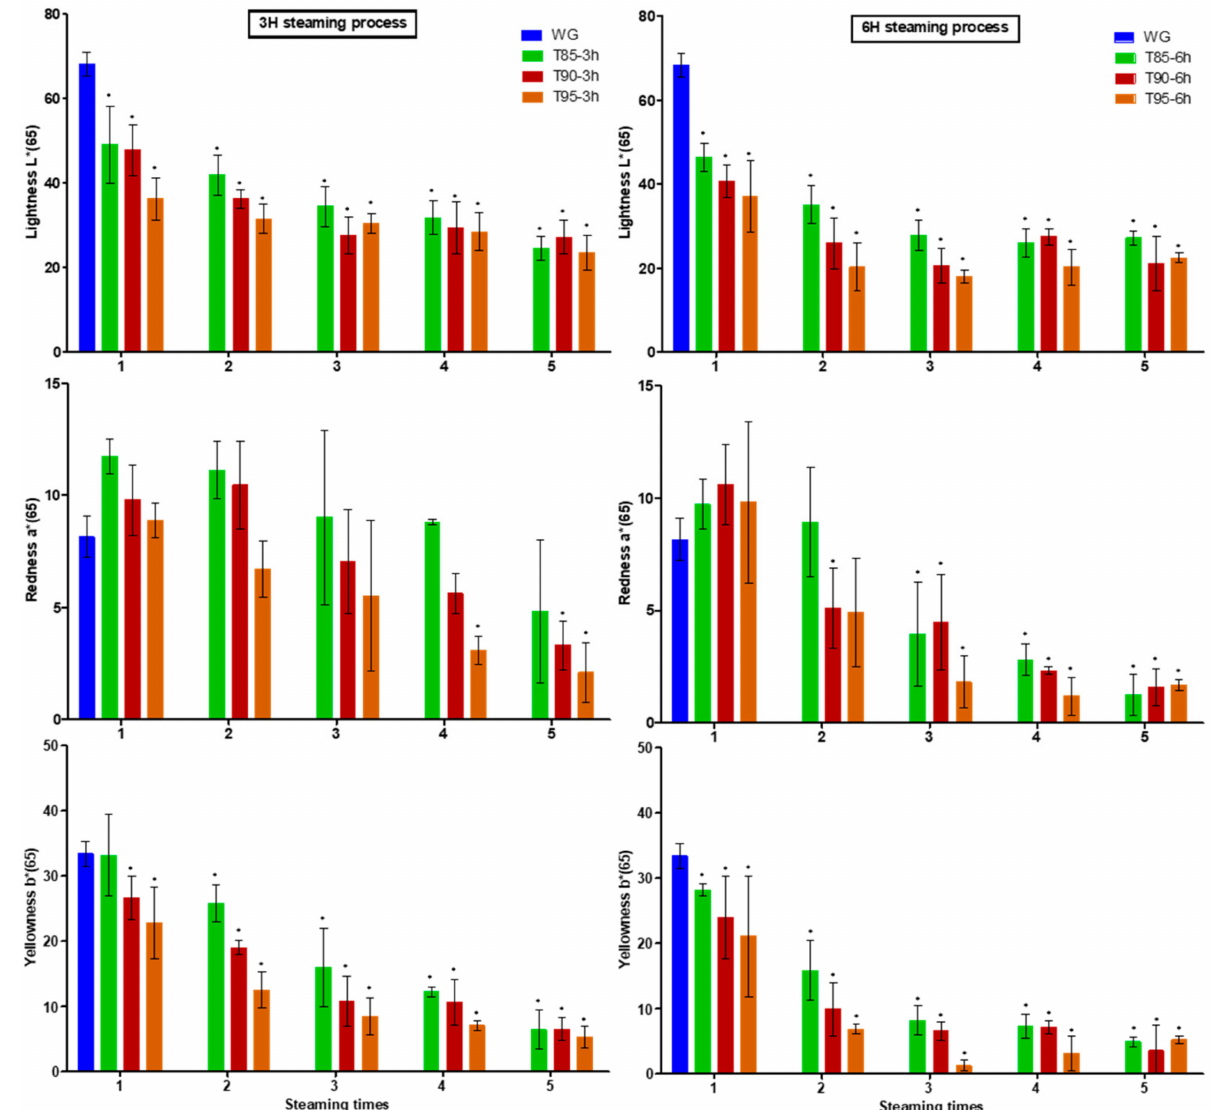
Figure 2. Change in appearance of black ginseng during steaming; L: Lightness; a: Redness; b: Yellowness; WG: white ginseng; T: temperature; h: steaming time. * p < 0.05, compared with WG. The color ∆ E value of SG was from 76.42 ± 0.08 to 24.19 ± 0.05 in the 95 ◦ C 3-h steaming process, and the ∆ E value of HG was from 59.84 ± 4.33 to 23.35 ± 0.11. This means that the more that the SG goes through the heat treatment process, the higher the degree of browning. In the case of steaming at 95 ◦ C for 6 h, the L value, a value, and b value of the SG showed the greatest decreases. The difference in color difference between SG and HG during heat treatment is shown in Figure